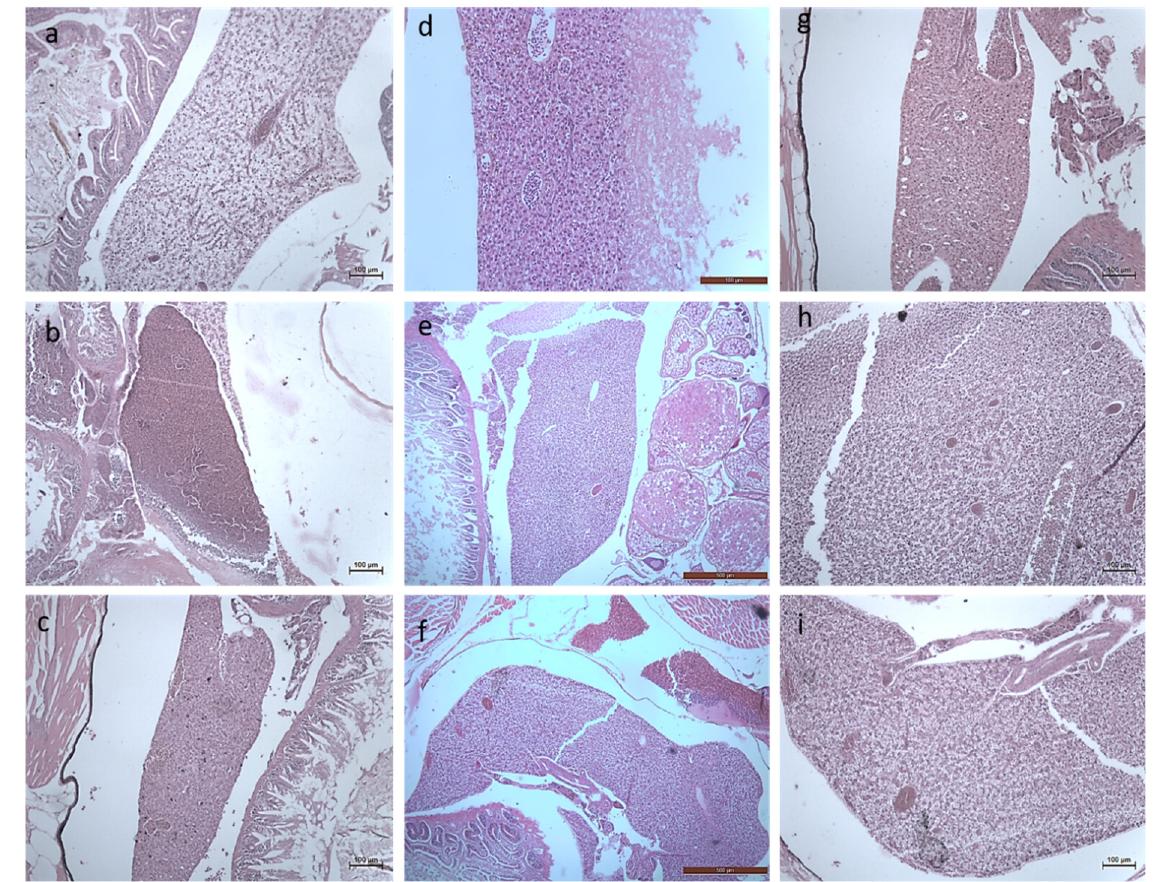
Figure 17. Histology images of liver of Zebrafish— Danio rerio (10X Magnification) ( a ) 10th day control, ( b ) exposed to 10 µg at 10th day, ( c ) exposed to 20 µg at 10th day; ( d ) 20th day control, ( e ) exposed to 10 µg at 20th day, ( f ) exposed to 20 µg at 20th day; ( g ) 30th day control, ( h ) exposed to 10 µg at 30th day, ( i ) exposed to 20 µg at 30th day.